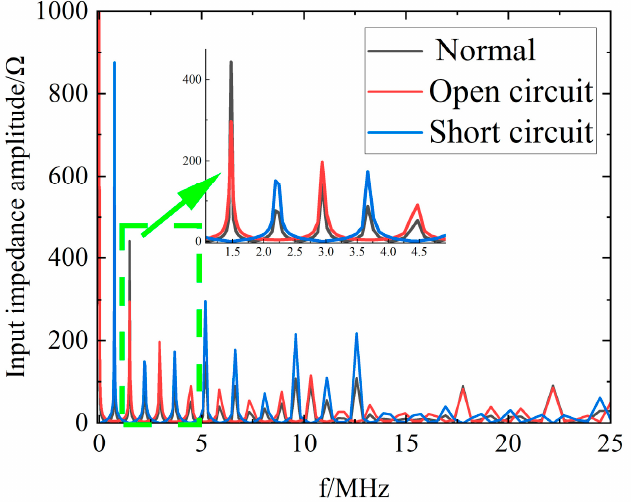
Figure 4. Headend input impedance amplitude spectrum of normal operation, open circuit, and short circuit cables.